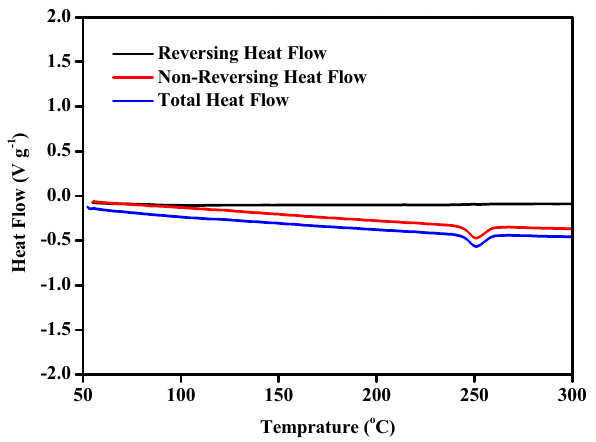
Figure 6. MDSC measurements of z-TACOT.